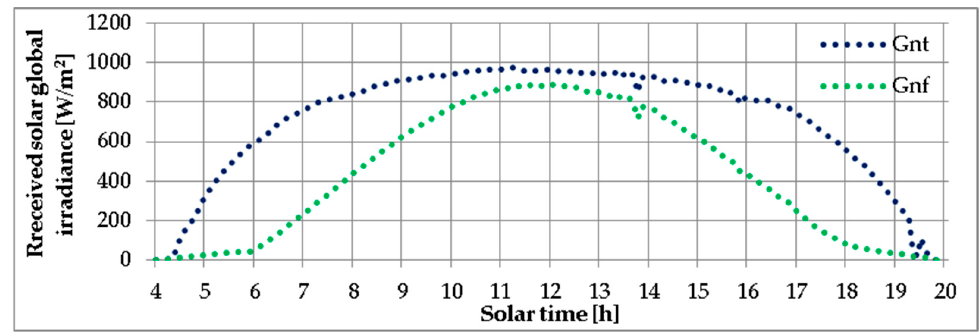
Figure 11. Solar global irradiance received by the tracked ( G nt ) and fixed ( G nf ) PV platforms on 29 June 2022.